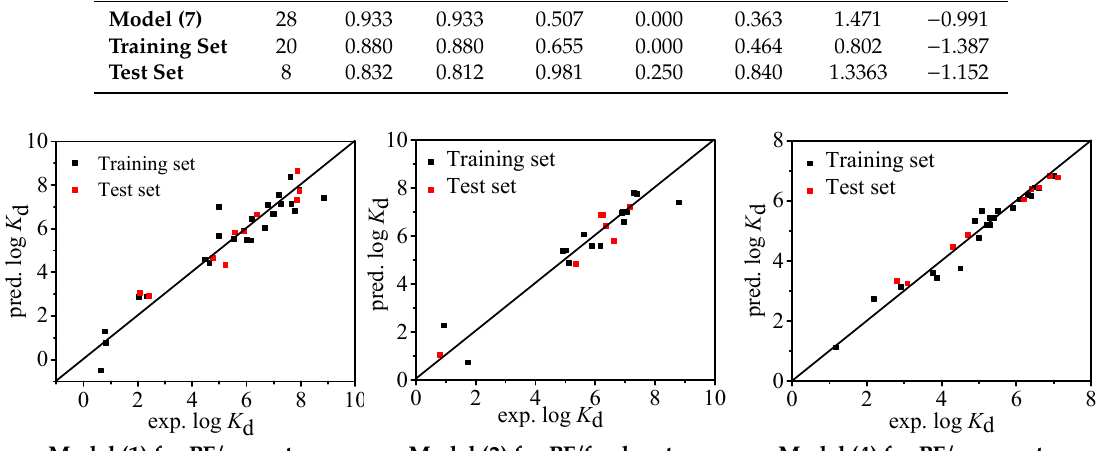
Figure 1. Fitting plots of experimental and predicted log K d by Models (1), (2), and (4). PE,